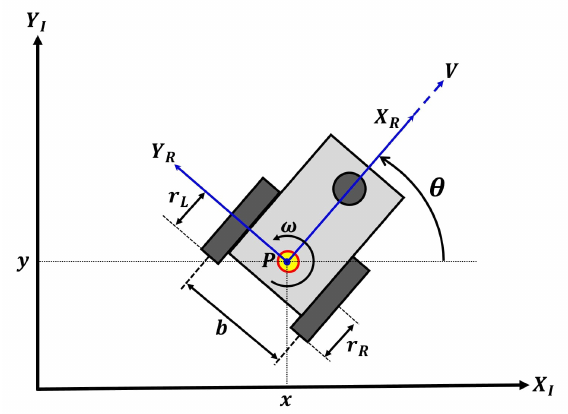
Figure 2. Mobile robot odometry and its relevant